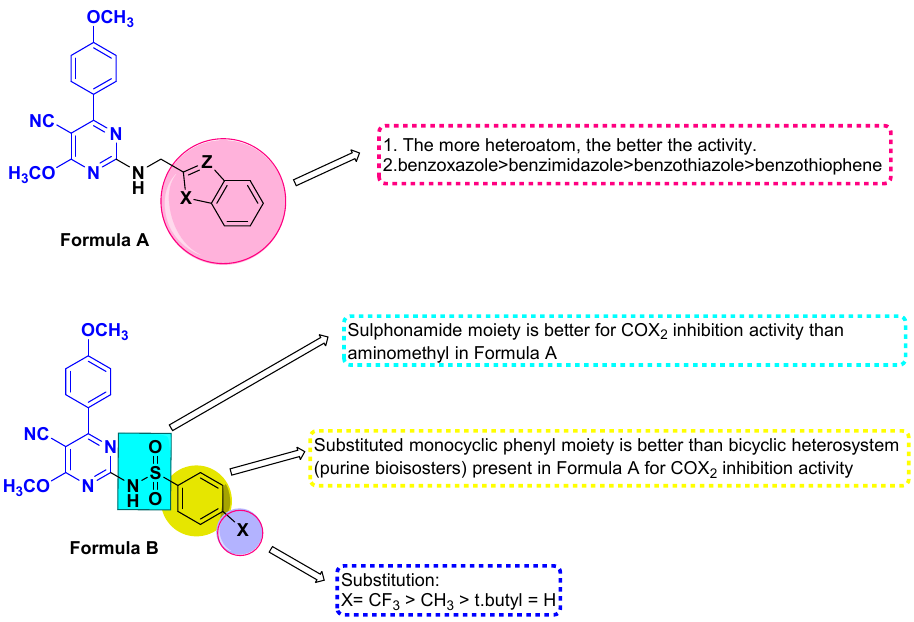
Figure 3. Structure activity relationship for the new targets as COX-2 inhibitors.